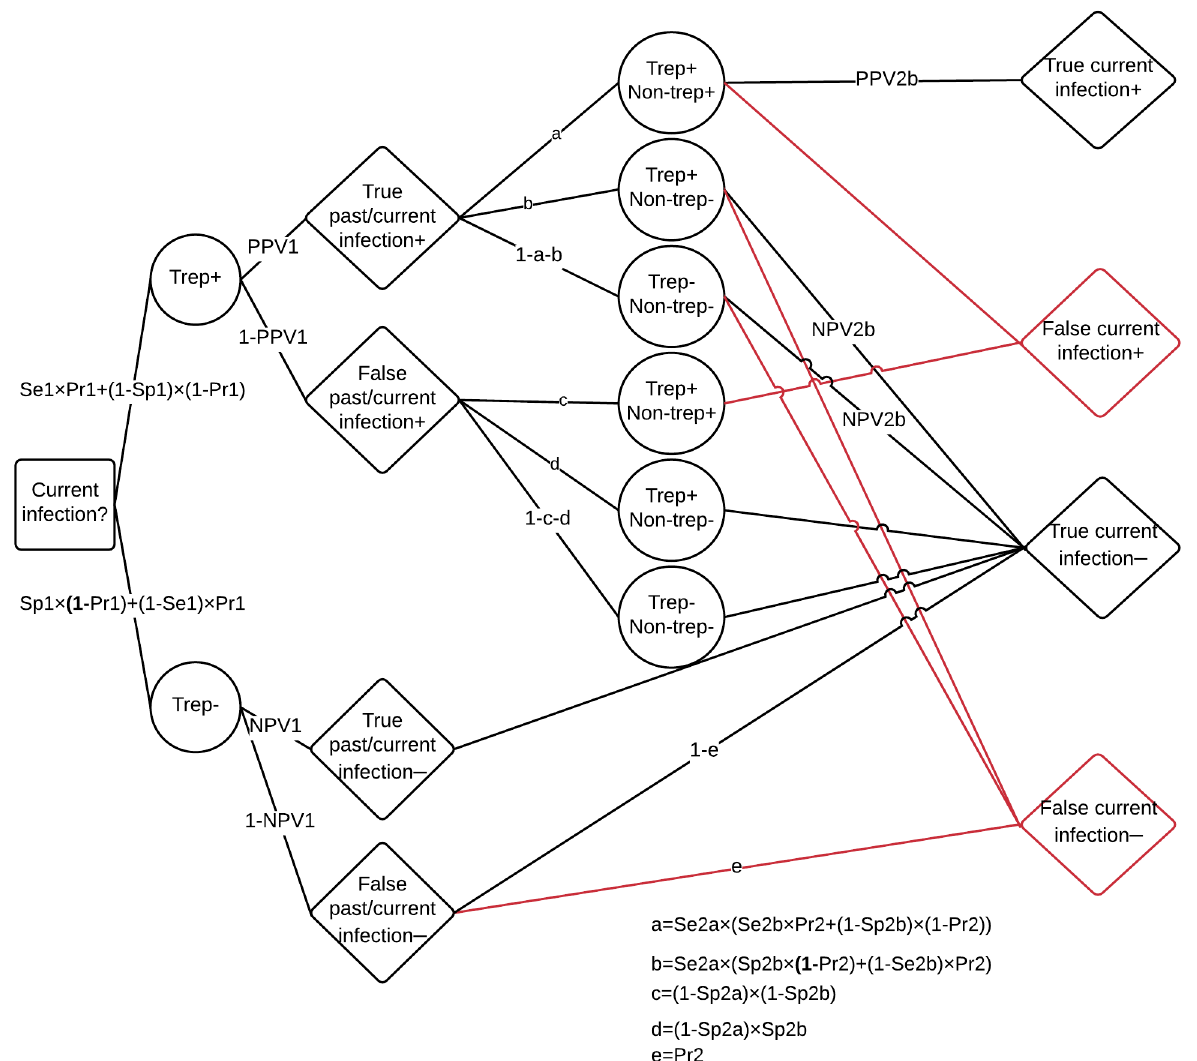
Fig 3. Decision model of diagnosis of current infection under the sequential testing strategy. In the sequentialstrategy, the individual’s first test result (circles) can be either: treponemal positive (suggestingpast/current infection), or treponemal negative (never any infection); this dependson the Sensitivity (Se) and Specificity(Sp) of the treponemal RDT (Se1 and Sp1, respectively), as well as on the prevalence of past/current infectionin the total population (Pr1); the treponemal line provides either a true or false diagnosisof past/ current infection; this dependson Positive Predictive Value (PPV) and NegativePredictive Value (NPV) of the treponemal RDT (PPV1 and NPV1, respectively); PPV is calculatedas (Se × Pr1) (cid:4) (Se × Pr1+(1–Sp) × (1–Pr1)); NPV is calculatedas Sp × (1–Pr1) (cid:4) ((1-Se) × Pr1 +Sp × (1–Pr1)); those with a true negativeresult for past/current infectionare logicallyalso truly negative for current infection; among those with a false negativeresult for past/current infection, we assume that the prevalence of current infectionamongfalse past/current infectionnegativesis the prevalence of current infectionin the population of past/current infections(Pr2); those with either true or false positive results for past/current infection receivea second test; their second test result can be either: dually positive (suggesting current infection), treponemal positive only (past infection), or duallynegative (never any infection);for simplicity, we assume that we use only the non-treponemal line; the non-treponemal line provides either a true of false diagnosisof current infection; this dependson PPV and NPV of the non-treponemal line (PPV2b and NPV2b),using the prevalence of current infectionin the populationof past/current infections(Pr2); red lines indicatepathways to false diagnoses of current